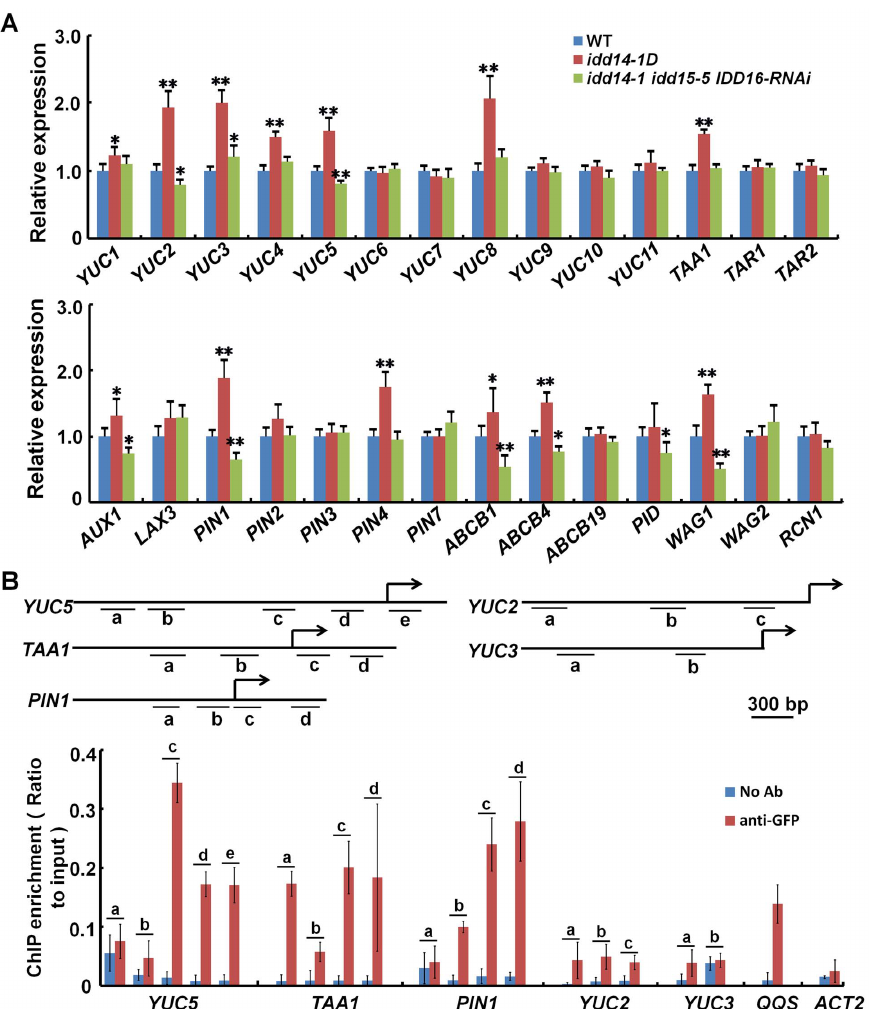
Figure 7. IDD Activates the expression of auxin biosynthetic and transport genes. (A) Relative expression levels of the genes involved in auxin biosynthesis (top panel) and transport (bottom panel) in WT, idd14-1D , and idd triple mutant plants. RNAs isolated from aerial organs of 4-week- old plants were subjected to qRT-PCR analysis, and the data are from three biological replicates and shown as mean values 6 one SD (Student’s t - test, *P , 0.05 and **P , 0.01). (B) ChIP assay performed with p35S::IDD16-GFP transgenic plants by anti-GFP antibody. The DNA fragments with a putative IDD-binding motif in the promoter and upstream regions of YUC5 , TAA1 , PIN1 , YUC2 , and YUC3 are indicated as the letters a–e (top panel), and the enrichment values of their PCR products were quantified by qPCR (bottom panel). A reported IDD-targeted fragment in the QQS promoter and a fragment in the ACT2 promoter were used as the positive and negative controls, respectively. The data are from three biological replicates and shown as mean values 6 one